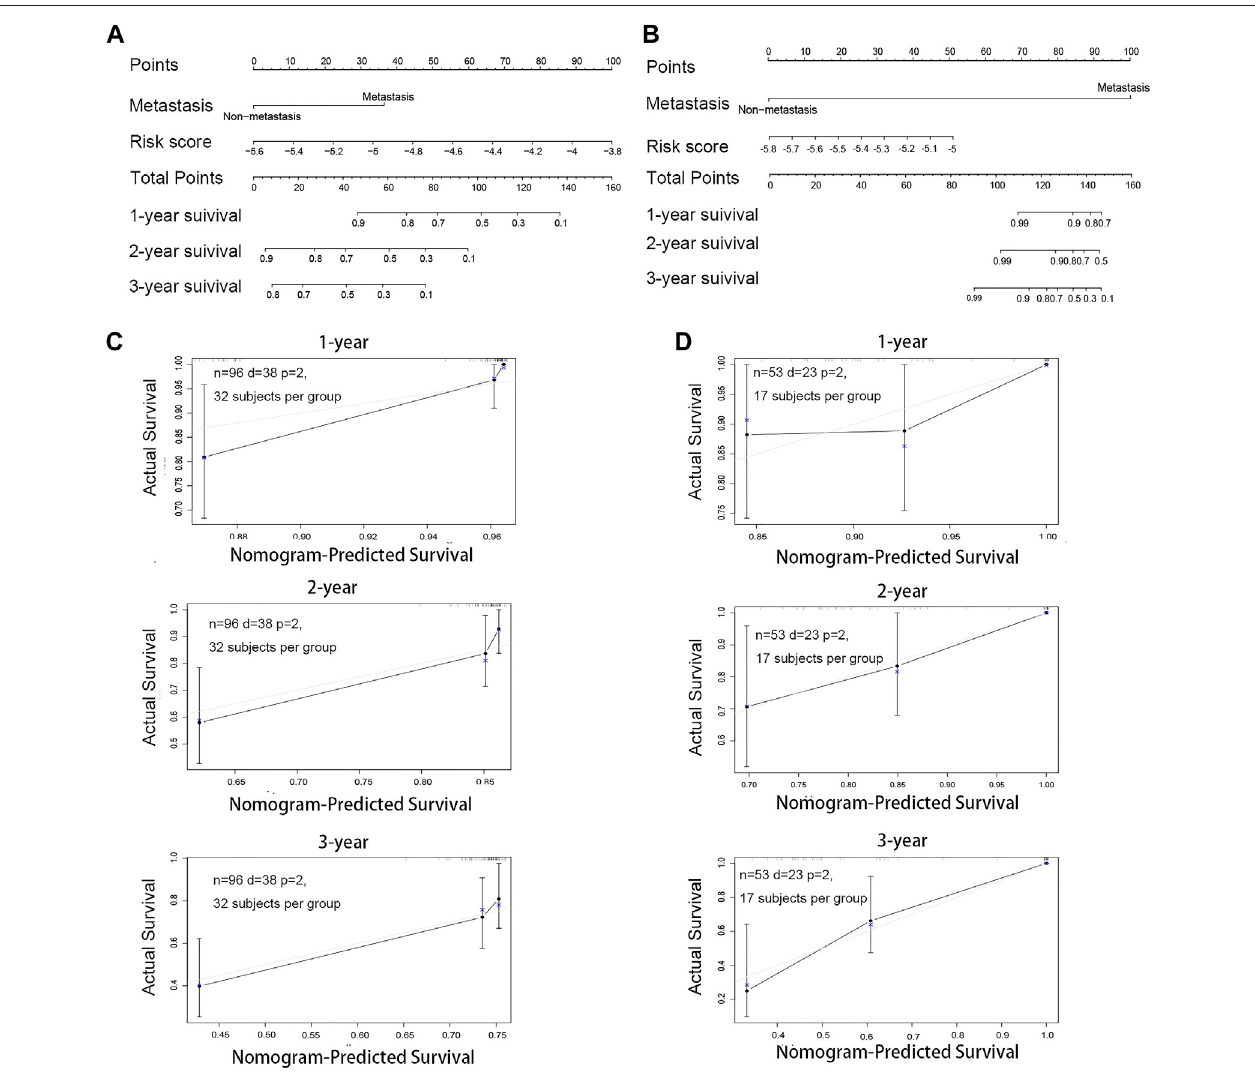
FIGURE6| Constructionandvalidationofthenomogramforosteosarcomapatients. (A) Nomogramforpredictingthe1-,2-,and3-yearsurvivalratebymetastasis and the risk score based on TARGET. (B) Nomogram for predicting the 1-, 2- and 3-year survival rate by metastasis and the risk score based on GSE21257. (C) Calibration curve of the 1-, 2- and 3-year survival rate based on TARGET. (D) Calibration curve of the 1-, 2-, and 3-year survival rate based on GSE21257.